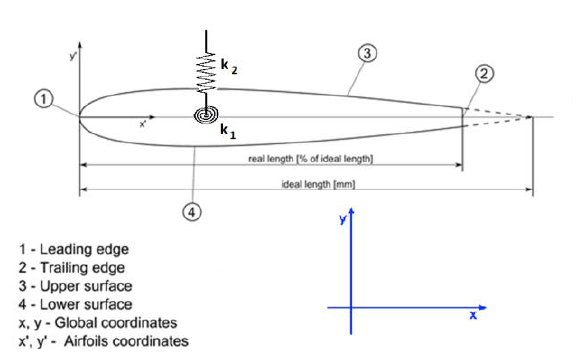
Fig. 1. Schematic view of used profile and its support using elastic elements.